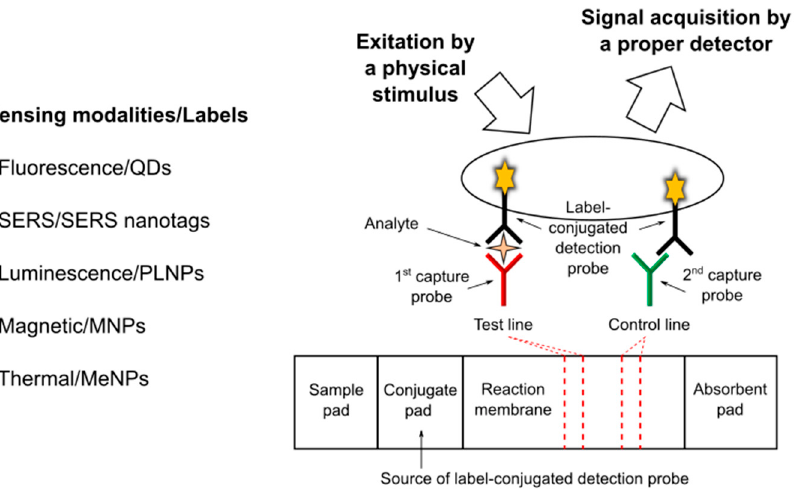
Figure 6. Simplified schematics summarizing the main sensing modalities and associated labels for high-sensitivity non-colorimetric detection methods applied to LFTs. QDs, quantum dots; SERS, surface enhanced Raman scattering; PLNPs, persistent luminescence nanoparticles; MNP, magnetic nanoparticles; MeNPs, metallic nanoparticles.